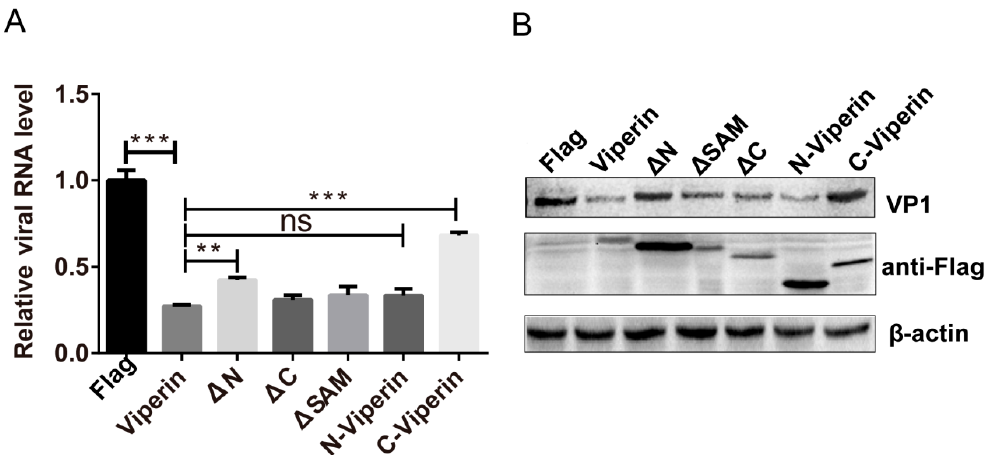
Figure 7. The N-terminal domain was responsible for viperin inhibition of EVA71 replication. 293T cells were transfected with FLAG-viperin, ∆ N, ∆ SAM, ∆ C, FLAG-N-viperin, or FLAG-C-viperin for 24 h, and then infected with EVA71 at an MOI = 1 for 12 h. The cells were lysed and EVA71 ( A ) RNA levels were measured using q-PCR, while ( B ) VP1 protein levels in the infected cells were analyzed using western blotting. Data are representative of at least three independent experiments performed in triplicate (mean ± SD of fold change). ** indicates p < 0.01, *** indicates p < 0.001 and “NS” indicates there was no significant difference between the two groups.